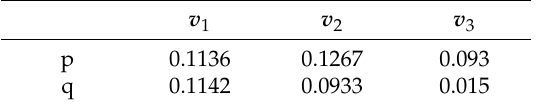
Table 2. Degree table of agree- neutrosophic soft expert multiset.